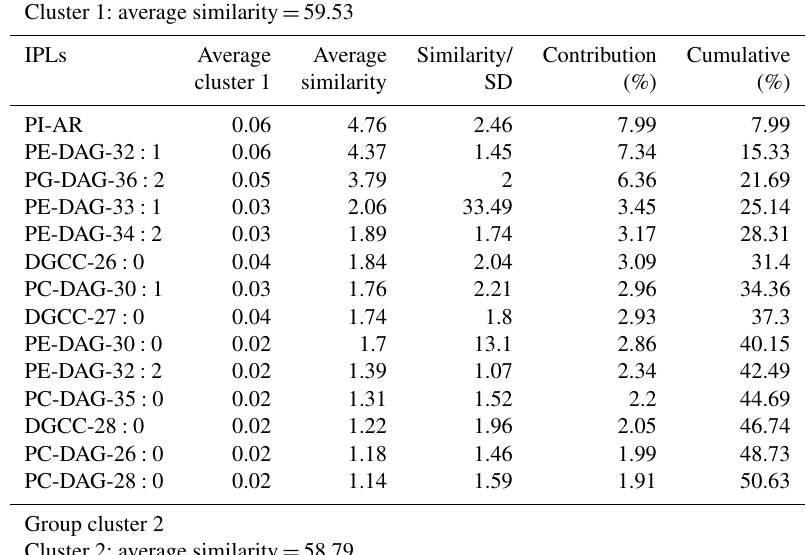
Table 2. Similarity percentage (SIMPER) analysis. The average abundance and contribution of IPLs that explain the main differences among the sediment samples is based on the hierarchical clusters shown in Fig.